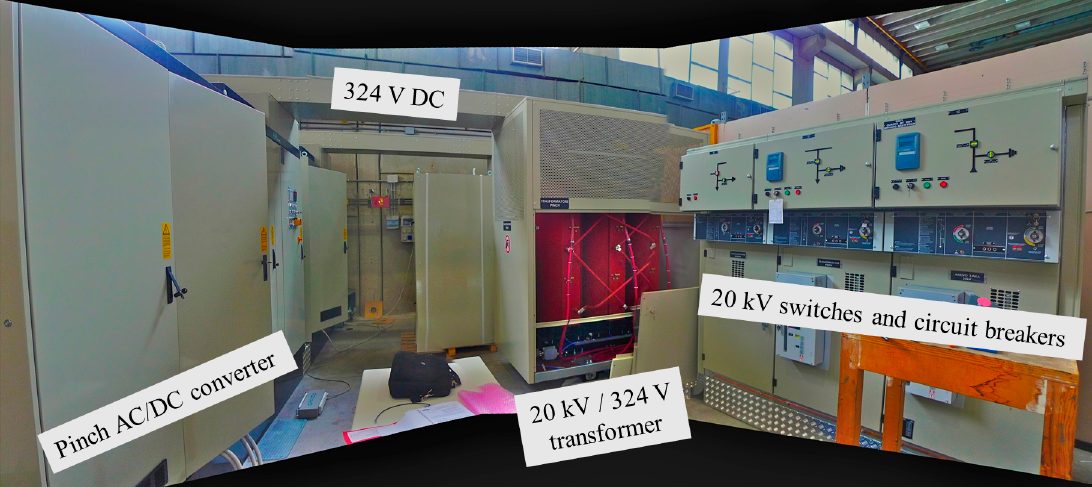
Figure 12. Power supply cubicle in the PROTO ‐ SPHERA hall.